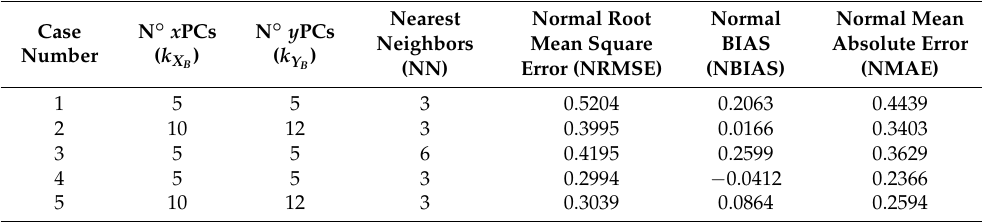
Table 1. Performance Indexes: Proposed Method.